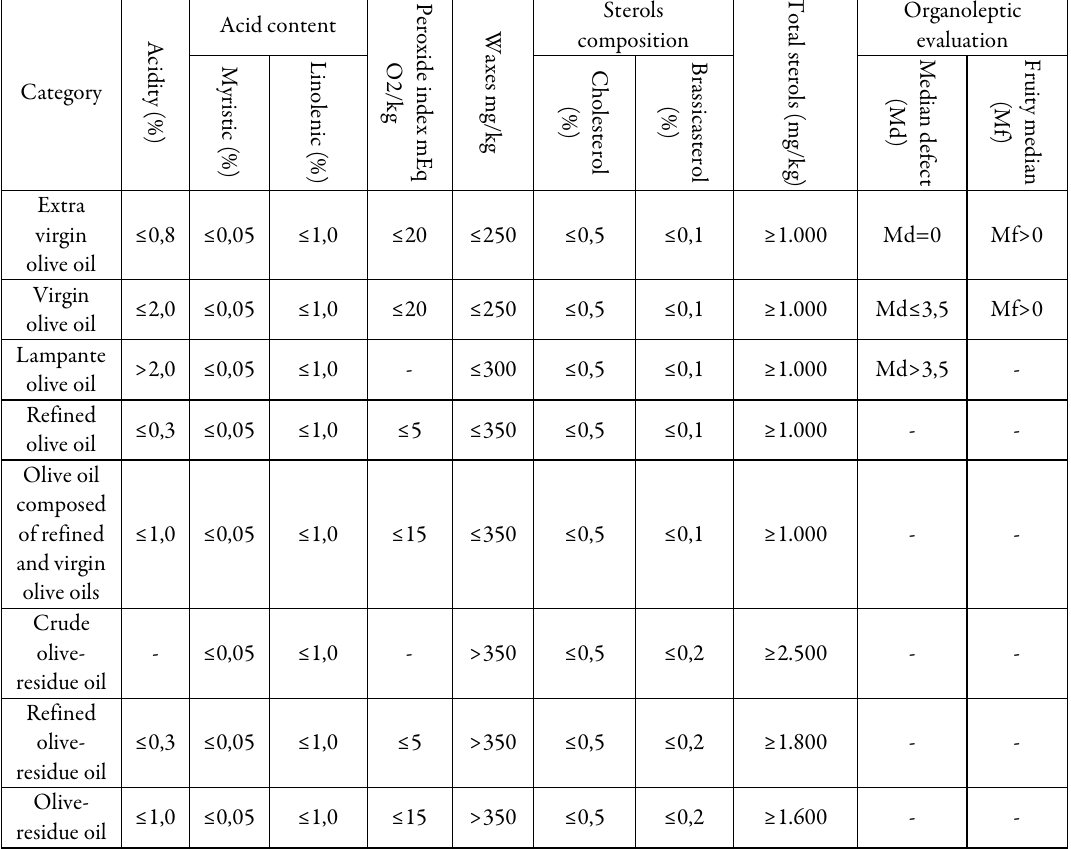
Table 1. Olive oils characteristics as presented by the official journal of the European Union (27/01/2011)